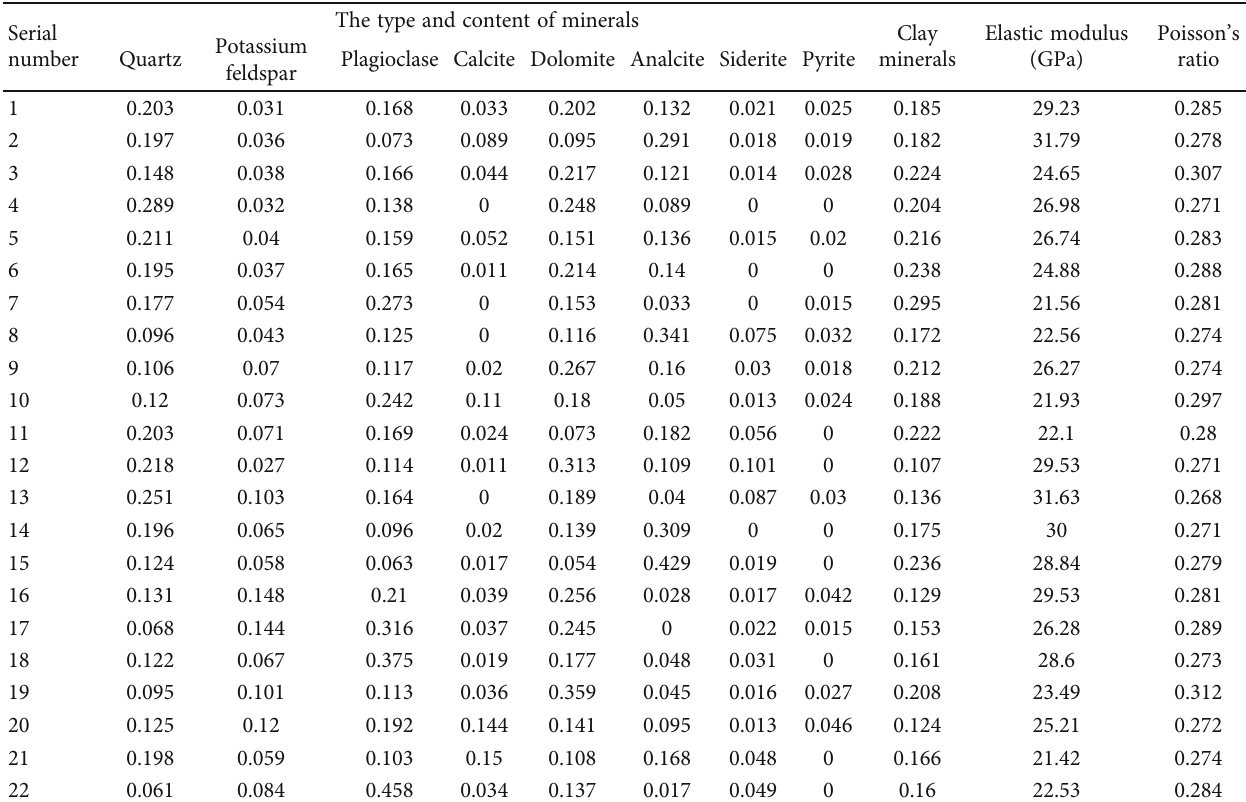
Table 1: The determination result of core mineral compositions and mechanical parameters.